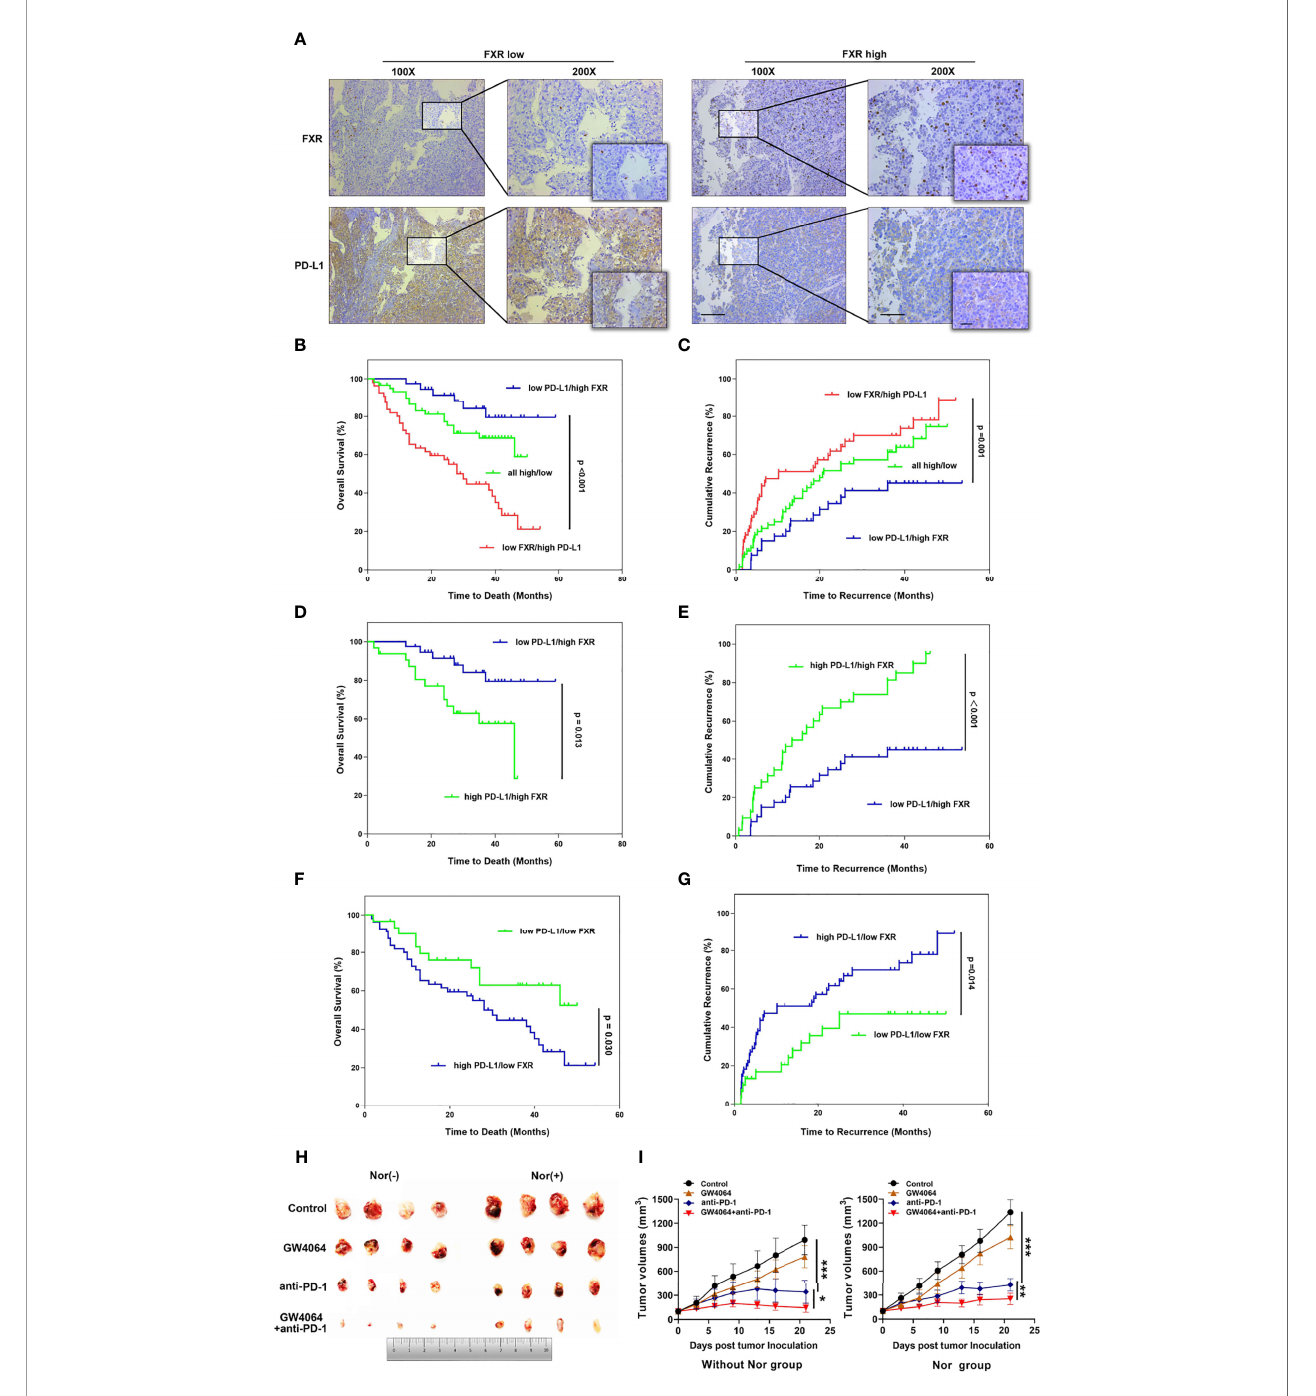
FIGURE 5 | The relevance of FXR to PD-L1 level in HCC samples and the FXR agonist exerting synergistic effects with anti-PD-1 Ab in the mouse model. (A) Immunohistochemical staining was performed with 156 HCC tissues. Representative images of FXR low PD-L1 high staining and FXR high PD-L1 low staining of serial sections of HCC tissues are displayed at 100× (left graph), 200× (right graph), 400× (right small graph) magni fi cations (scale bar, 100 µm). (B, C) The OS and TTR of postoperative HCC patients based on both FXR and PD-L1 expression. Patients with FXR low PD-L1 high displayed the shortest OS (p<0.001, log-rank test) and TTR (p=0.001, log-rank test). (D – G) The OS and TTR for 4 subgroups (FXR high PD-L1 high VS FXR high PD-L1 low , and FXR low PD-L1 high and FXR low PD-L1 low ). (H) Mice were inoculated subcutaneously with 1 × 10 6 Hep1-6 cells and treated with anti-PD-1 Ab, IgG2a, GW4064 or anti-PD-1+GW4064 after the tumors reached 100 mm 3 . (I) With (right graph) or without (left graph) NorCA exposure, the tumor growth in the single-agent therapy group (n = 5) was compared with the combination therapy group (n = 5). *p < 0.05, **p < 0.01, and ***p <